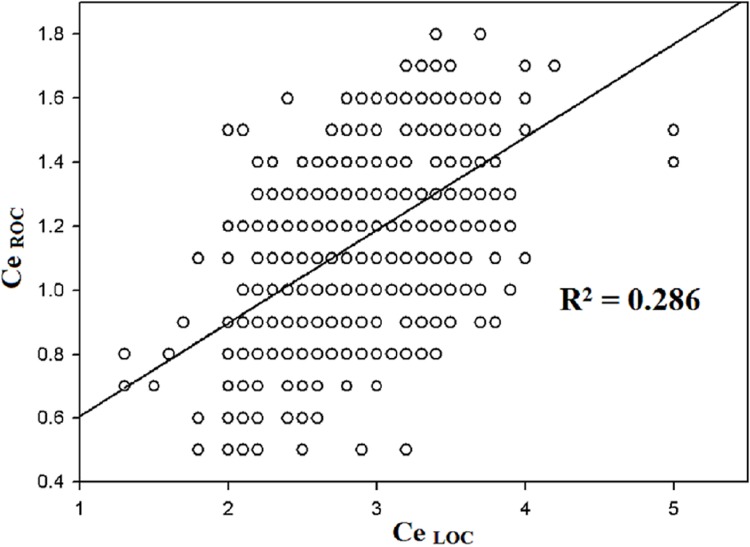
Linear regression between CeROC and CeLOC in 794 patients.Statistically significant correlation (R2 = 0.286; p < 0.01) and positive slope.